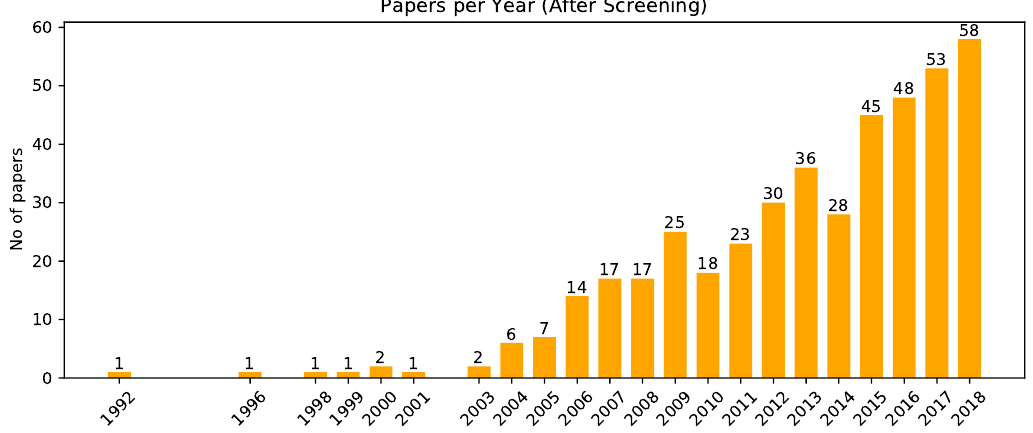
Figure 3. Papers on the topic, after the first screening of title and abstract and keywords.